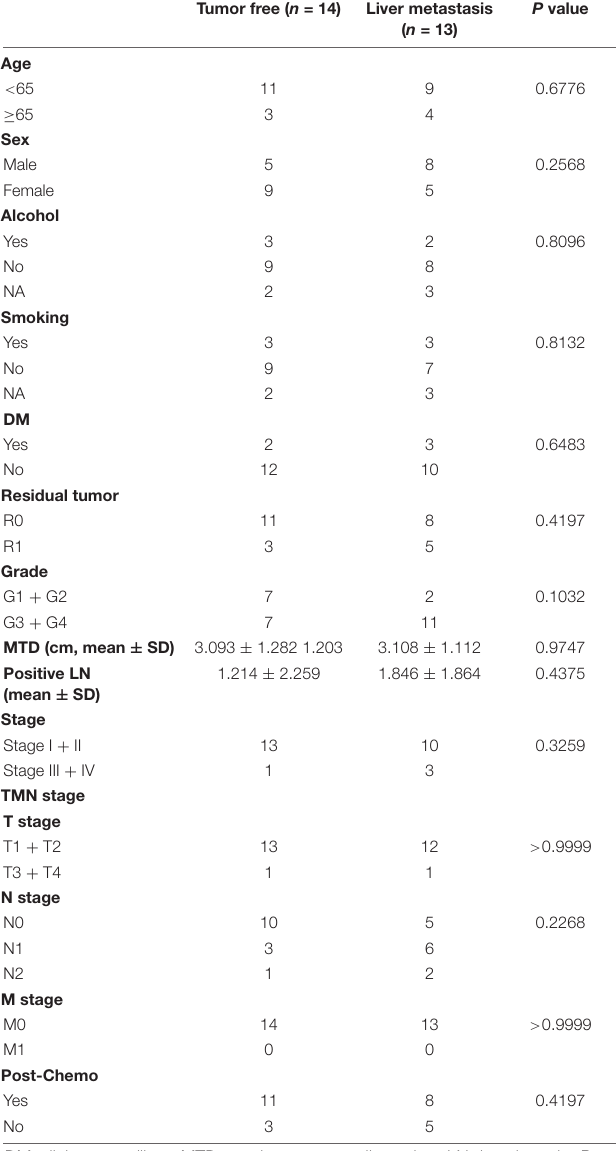
TABLE 1 | Patient baseline